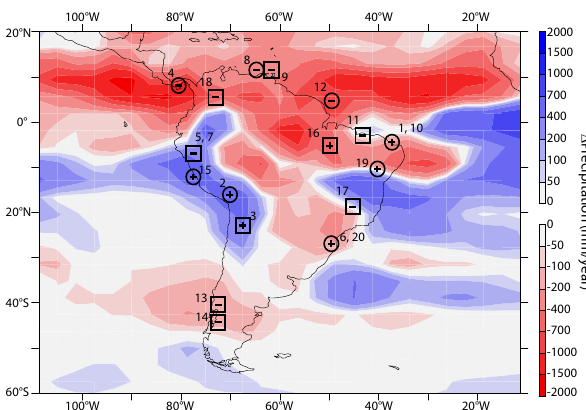
Fig. 11. Compilation of different reconstructions showing precipi- tation and vegetation changes in South America during the Younger Dryas event (ca. 12kyrBP). Plus (+) sign indicates dryer condi- tions during the event and minus ( − ) sign wetter. Square frames around the signs are used for vegetation proxies, whereas circle frames are for precipitation proxies in general. The colour shad- ing in the background shows the 10-year average annual precip- itation anomaly by the end of the perturbation in the experiment 1.0NA. The numbering of the studies is as follows: 1. Arz et al. (1998), 2. Baker et al. (2001), 3. Betancourt et al. (2000), 4. Bush et al. (1992), 5. Bush et al. (2005), 6. Cruz et al. (2005), 7. Hansen and Rodbell (1995), 8. Haug et al. (2001), 9. Hughen et al. (2004), 10. Jennerjahn et al. (2004), 11. Ledru et al. (2002), 12. Maslin and Burns (2000), 13. Massaferro et al. (2009), 14. Moreno (2000), 15. Rein et al. (2005), 16–17. Servant et al. (1999), 18. van’t Veer et al. (2000), 19. Wang et al. (2004), 20. Wang et al.